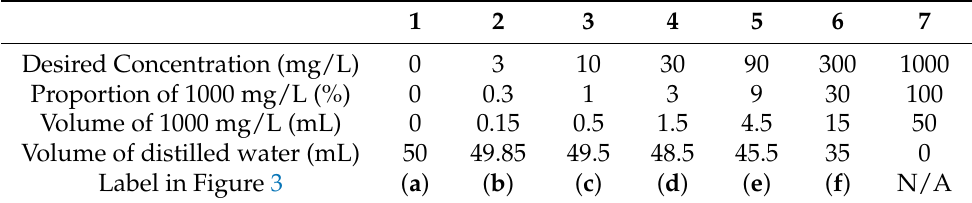
Table 1. 1000 mg/L nitrate dilutions to achieve various concentrations of nitrates in 50mL of distilled